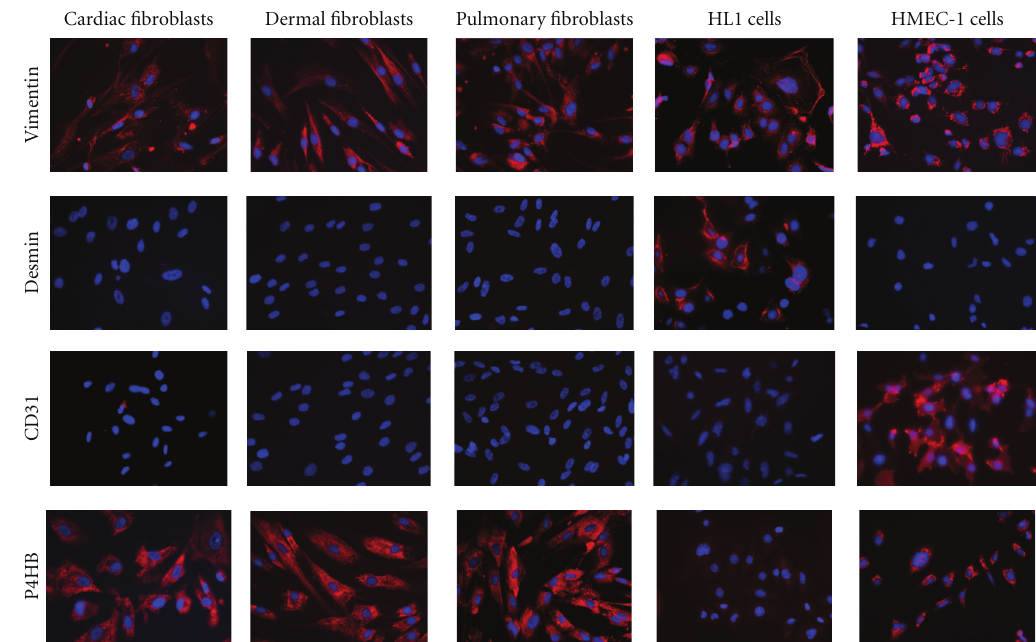
Figure 1: Characterization of primary human fibroblasts. Cells were obtained by outgrowth form tissue samples from heart, skin, and lung. They were stained with antibody directed against vimentin, desmin, CD31, and P4HB. They show positive staining for vimentin and P4HB and were therefore characterized as